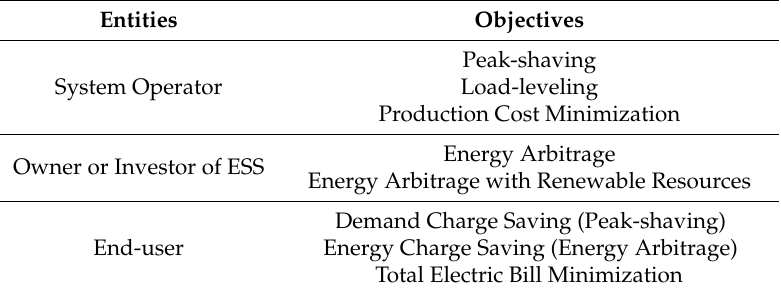
Table 1. Short-term energy time-shifting applications of ESSs in power